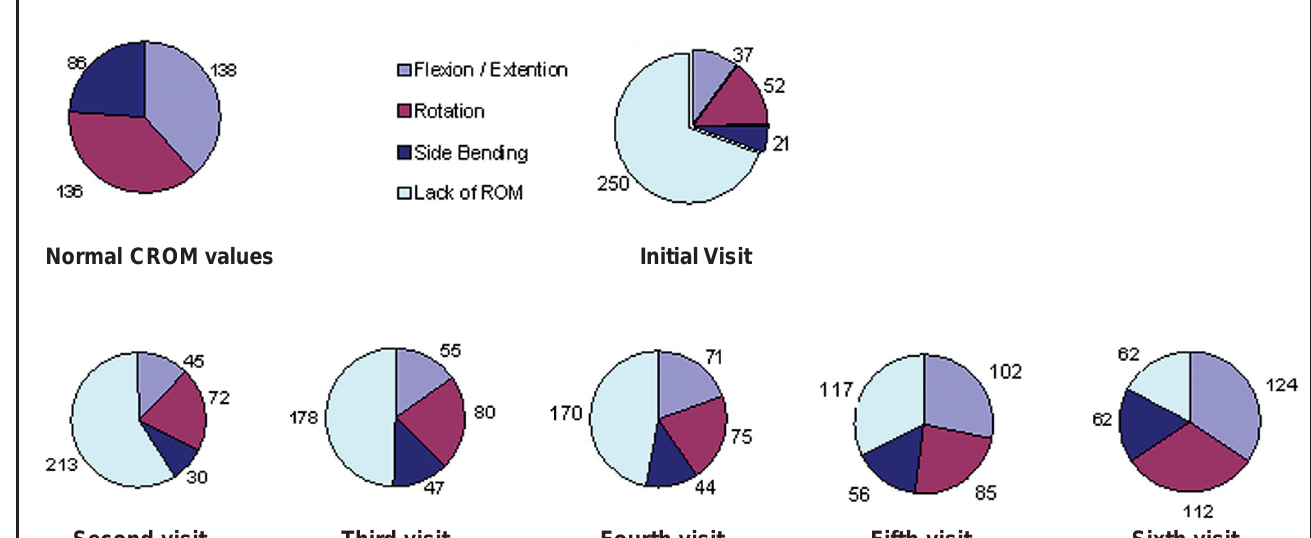
Figure 2: Summary of cervical range of motion changes during physiotherapy